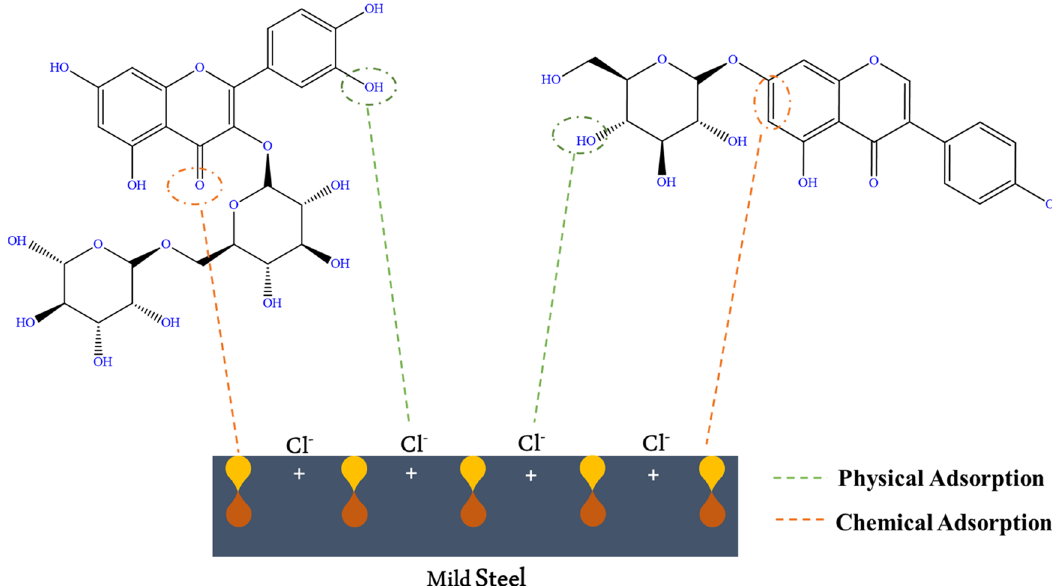
Figure 7. Schematic of the proposed mechanism of adsorption of FV leaves extract on MS